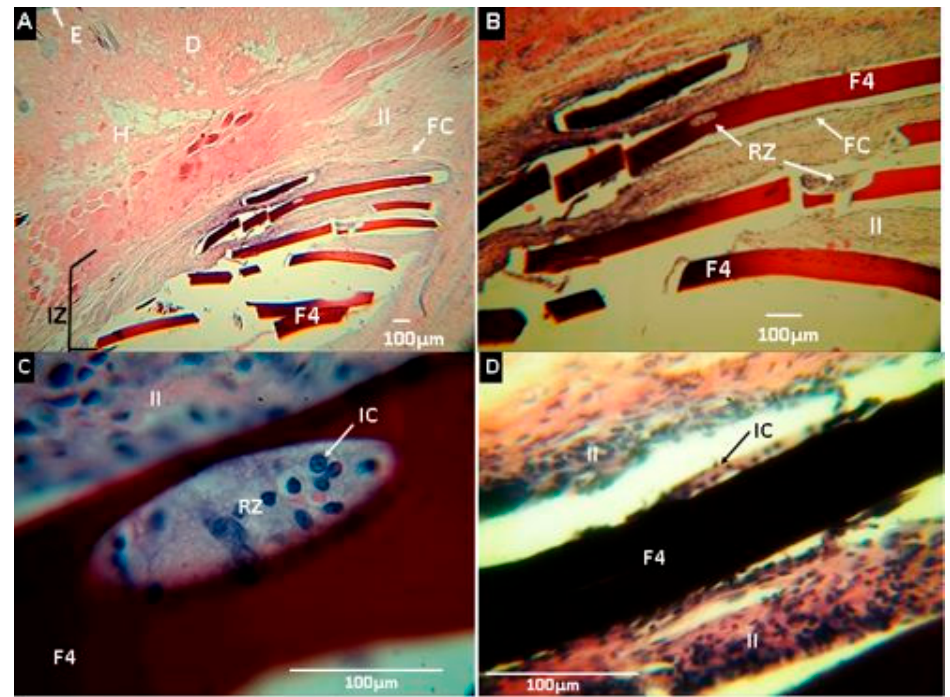
Figure 14. Histological analysis of experimental sample F4 (CS:PVA: CS-g-CNO 29.50:70.00:0.50). Magnifications are as follows: ( A ) 4× H&E, ( B ) 10× H&E, ( C ) 40× MT, ( D ) 100× MT. E: epidermis. D: Dermis. FC: Fibrous capsule. II: Inflammatory infiltrate. RZ: Reabsorption zone. IC: Inflammatory cells. F4: Film formulation 4(CS:PVA:CS-g-CNO 29.50:70.00:0.50). Hematoxylin and eosin (H&E) and